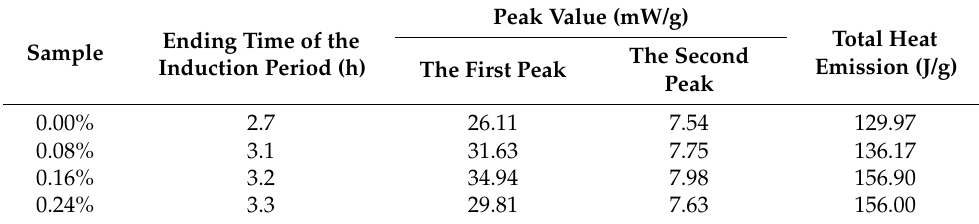
Figure 6. ( a ) Effect of NSN dosage on hydration heat flow; ( b ) effect of NSN dosage on total hydration heat. Table 4. Peak heat release of hydration heat and accumulated heat release.